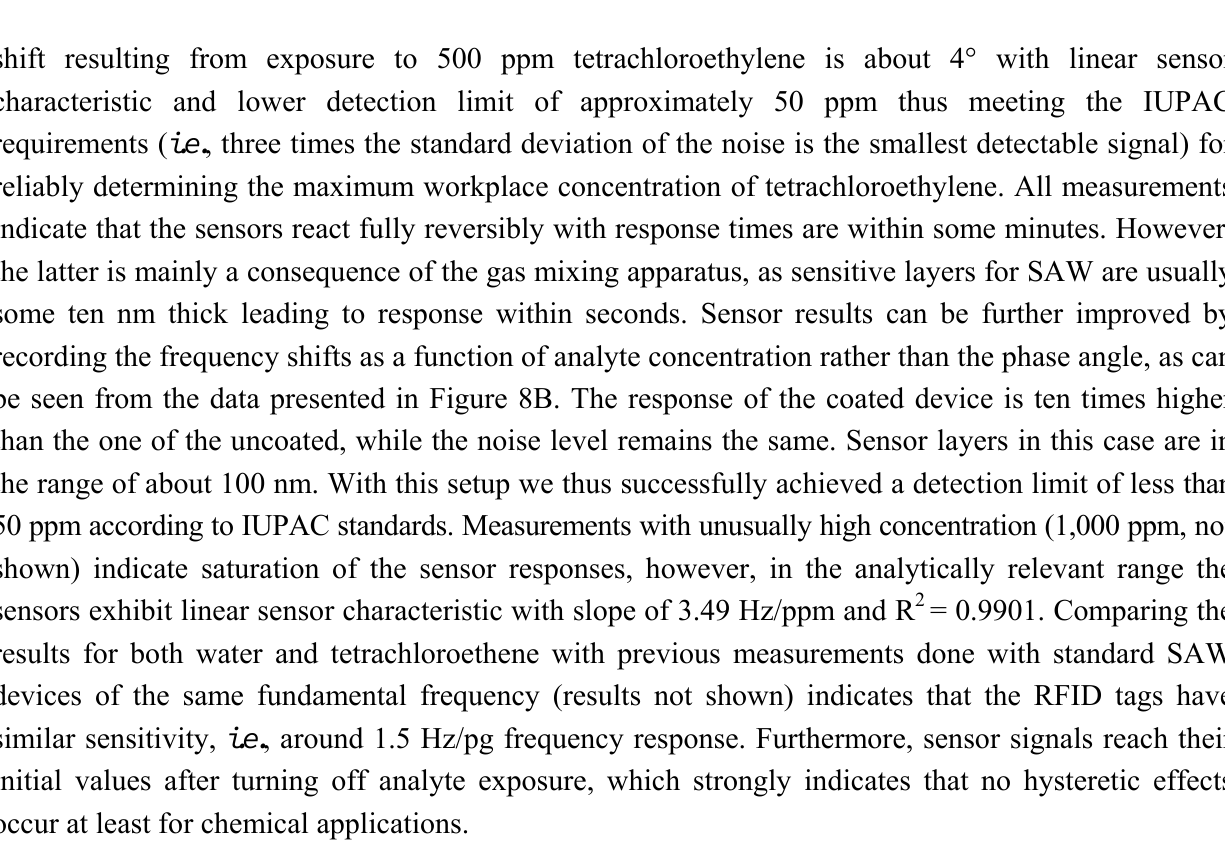
Figure 8. (A) Sensor response (phase shift at a distinct frequency) of tert.-butylcalix[4]arene coated RFID-Tag to various amounts of tetrachloroethylene (T = 20 °C, flow: 1 L/min), (B) corresponding frequency